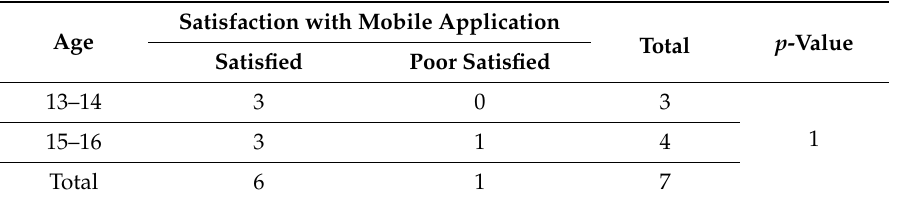
Table 6. Satisfaction with the mobile application by age.